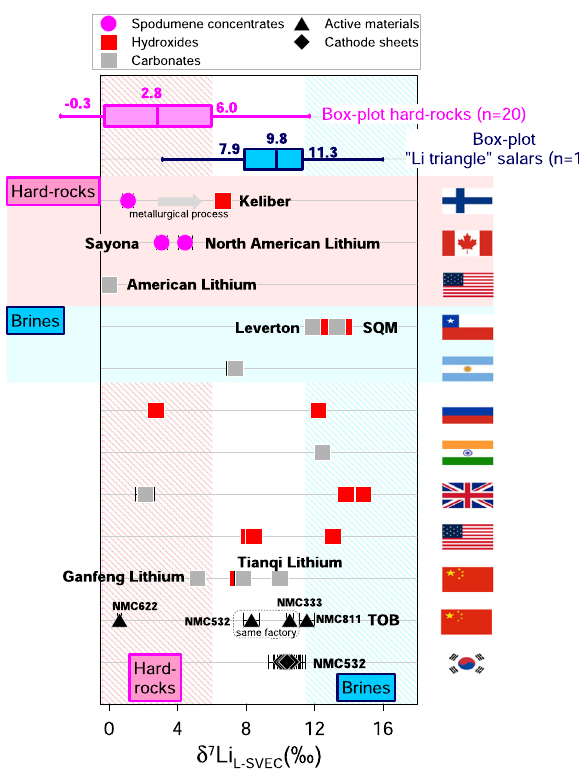
Fig. 4 Lithium isotope compositions of various battery precursors and components produced around the world (Finland, Canada, USA, Chile, Argentina, Russia, India, UK, China, and South Korea). Spodumene concentrates ( n = 3), lithium hydroxides ( n = 11), lithium carbonates ( n = 8), cathode active materials ( n = 5), cathode sheets ( n = 8). The lithium carbonate produced by American Lithium (L-SVEC) is also shown 51 . Error bars represent the 2 σ associated with δ 7 Li values. Data are shown with blue box-plots for “ Li triangle ” salars ( n = 103) 35 – 40 and pink box-plots for hard-rocks ( n = 20) 32 – 34 . The “ hard-rocks domain ” and “ brines domain ” de fi ned in this study are shown by pink and blue hatched areas, respectively. The “ unknown origin domain ” is shown by the white area between the two hatched